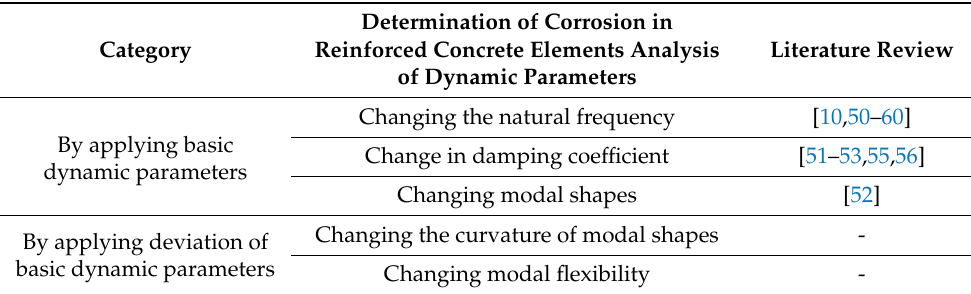
Table 2. Review of the literature related to individual methods of determining damage.